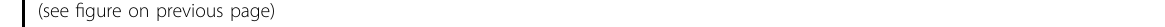
Fig. 2 The optical design of the FANTASIA system. a A single-pair AOD based two-photon imaging system with a simple architecture. BE (beam expander); M (mirror); DpCG (dispersion compensation grating); SRR (sliding retrore fl ector); DCU (dispersion compensation unit); HWP (halfwave plate); AODs (acousto-optical de fl ectors); DvCL (divergence compensation lens); SL (scan lens); TL (tube lens); TM (turning mirror); DF (dichroic fi lter); Obj (objective); Sub (subject); CLs (collection lenses); PMT (photomultiplier tube). b – d Schematics of scanning modes supported by the system. A basic scanning mode supported by an orthogonal pair of AODs is 2D random-access pointing ( b ). The system further supports 2D fast raster scanning ( c ) by chirping the AOD control signals on both axes at the same speed, while the beam divergence generated by the AODs is compensated with an additional convex lens (DvCL). The focal plane depth can be additionally shifted by adjusting the chirping speed of the AOD control signals, resulting in a 3D multi-layer raster scanning mode ( d ). e The effect of AOD chirping speed on the frame rate, the DvCL needed, and the FOV size in the 2D fast full-frame raster scanning mode in ( c ). The AOD chirping speed is expressed in line scan time, the time to linearly chirp across the AOD bandwidth (30 MHz). A shorter line scan time would result in a higher full-frame raster scanning rate, a need for a DvCL with a shorter focal length to fully compensate for beam divergence, and a wider dark periphery in the FOV due to the necessary transition time between the scanning lines. f Two-photon image acquired with the 2D fast full-frame raster scanning mode demonstrated in ( c ). The image is of a neuronal population labeled with GCaMP6s in marmoset auditory cortex at a ~200 μ m depth. Scale bar: 100 μ m. g The effect of AOD chirping speed on focal depth shift in the 3D multi-layer full-frame raster scanning mode ( d ) with an f = 1000 mm DvCL. The AOD chirping speed is expressed in line scan time as in ( e ). This effect is also DvCL- and objective- dependent. h Two-photon images acquired with the 3D multi-layer raster scanning mode demonstrated in ( d ). The fi ve scanned layers are spaced by a 5 μ m inter-layer distance. The images are of a testing slide (Invitrogen F36924) tilted at a 3.4° angle (~25 μ m depth change over the FOV). Scale bar: 100 μ m. i The spatial dispersion effect demonstrated by wide- fi eld images of